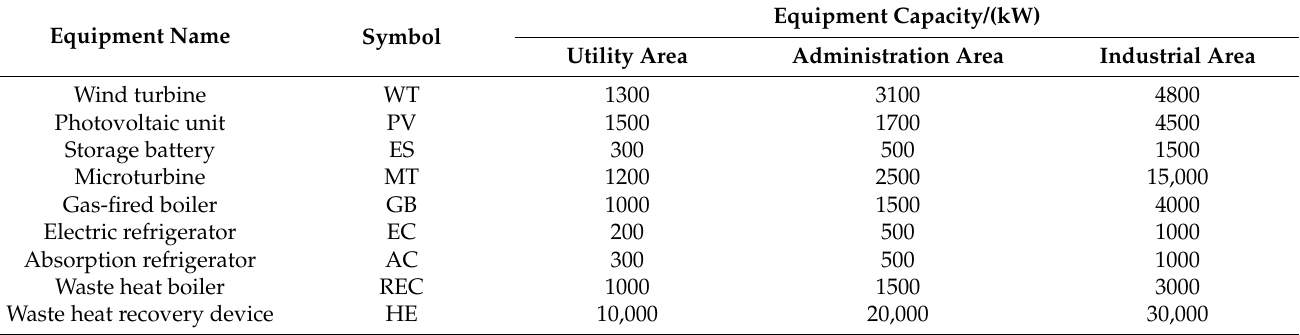
Table 2. Scope of middle pipe section in each